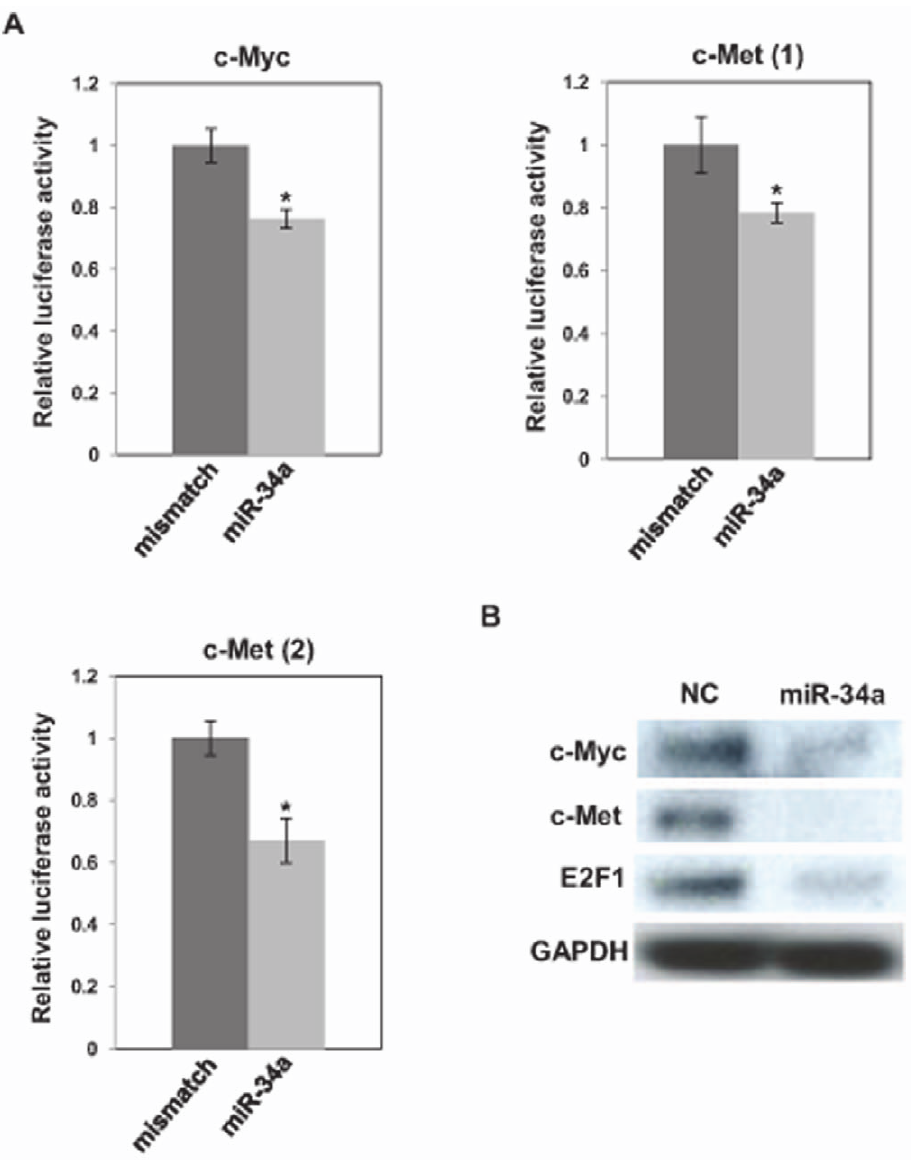
Figure 3. miR-34a targets oncogenes in PC-3 cells. (A) PC-3 cells were transiently transfected with pre-miR negative control (NC) or pre–miR- 34a or pre–miR-con for 8 h, followed by transient transfection with control reporter plasmids or 3 9 UTR plasmids for 48 h. 3 9 UTR reporter activity was measured by luciferase assay and normalized to activity of Renilla luciferase. *, P , 0.05 compared with control. (B) PC-3 cells were transiently transfected with pre-miR negative control (NC) or pre–miR-34a or pre–miR-con for 72 h. Protein expression level was analyzed by Western